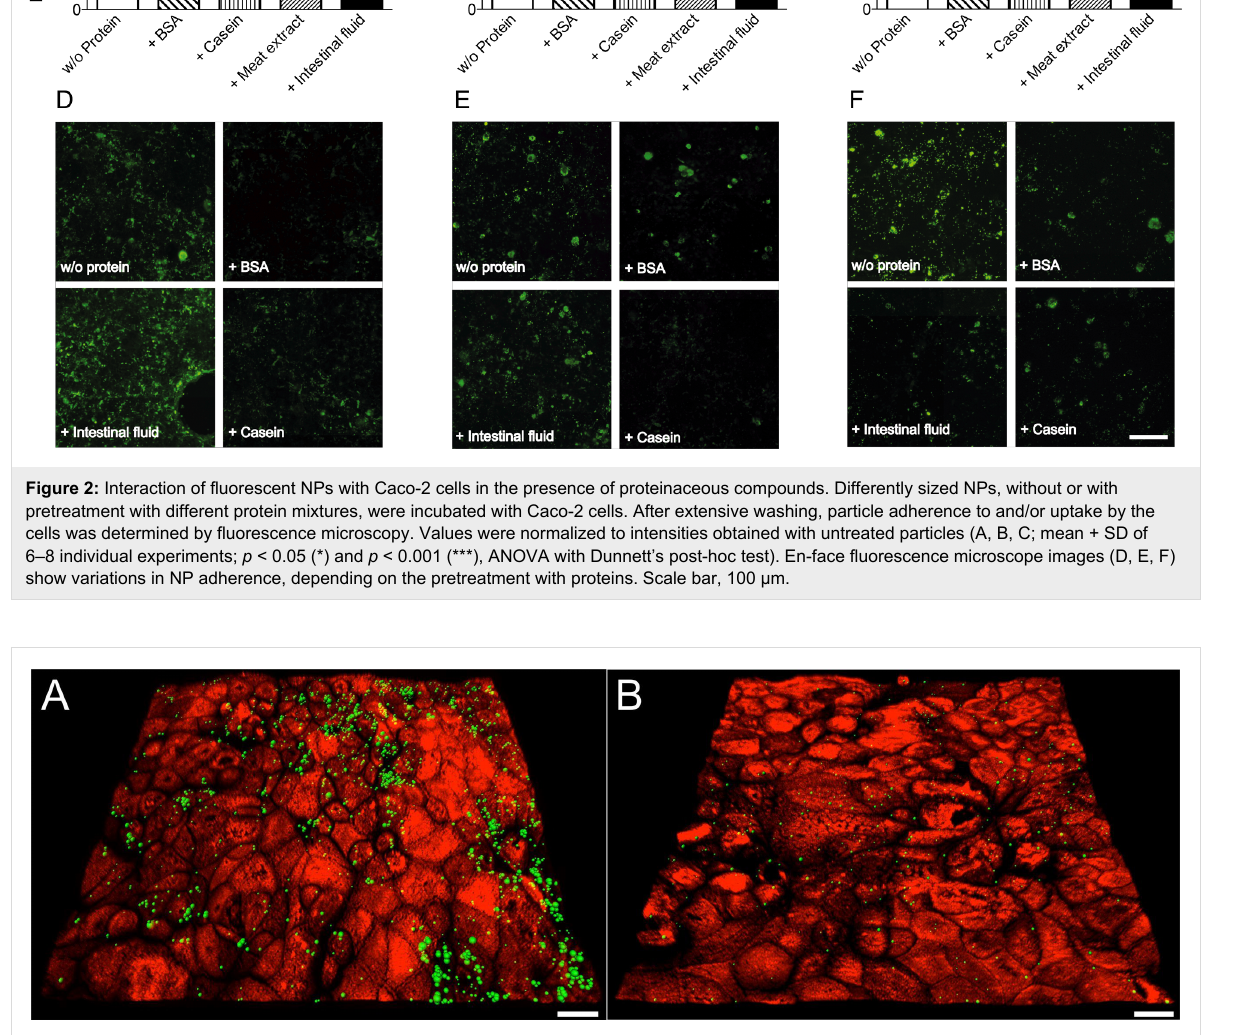
Figure 3: Adherence of 100 nm NPs to Caco-2 cells. The glycocalyx was counter-stained with a lectin (red) to visualize the cell surface of the mono- layer. Stacks of 2-dimensional microscope images were processed with the software Imaris x64 to give a 3D rendition. A: In the absence of BSA, NPs are attached to the cell surface mainly in form of particle agglomerates (green spots in variable size). B: After preincubation of NPs with BSA only few and small particle spots are visible. Scale bar: 15